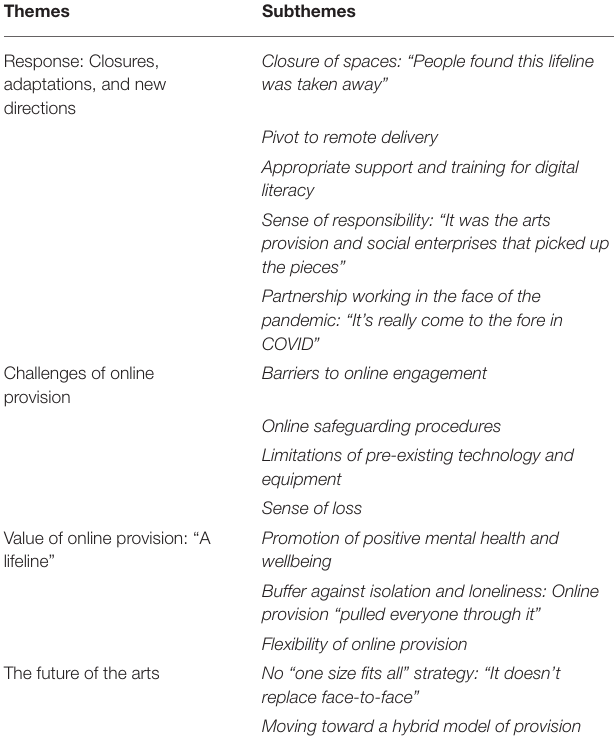
TABLE 1 | Overarching themes and